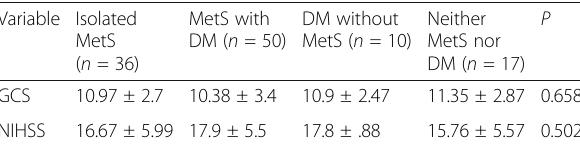
Table 2 Clinical assessment at presentation Variable Isolated MetS